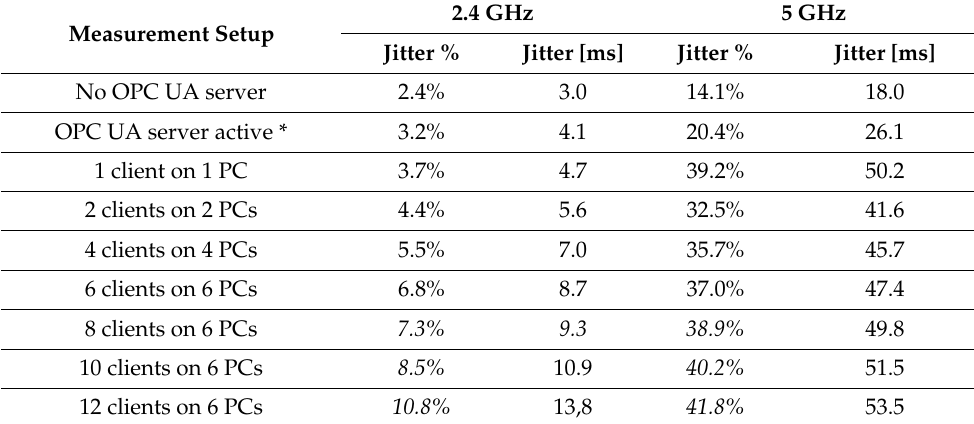
Table 3. Results for the wireless connection with an update time of 128